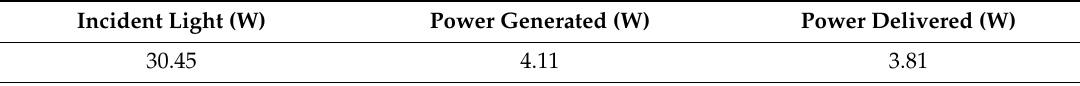
Table 1. Power generated from the solar panel and power delivered to the battery.